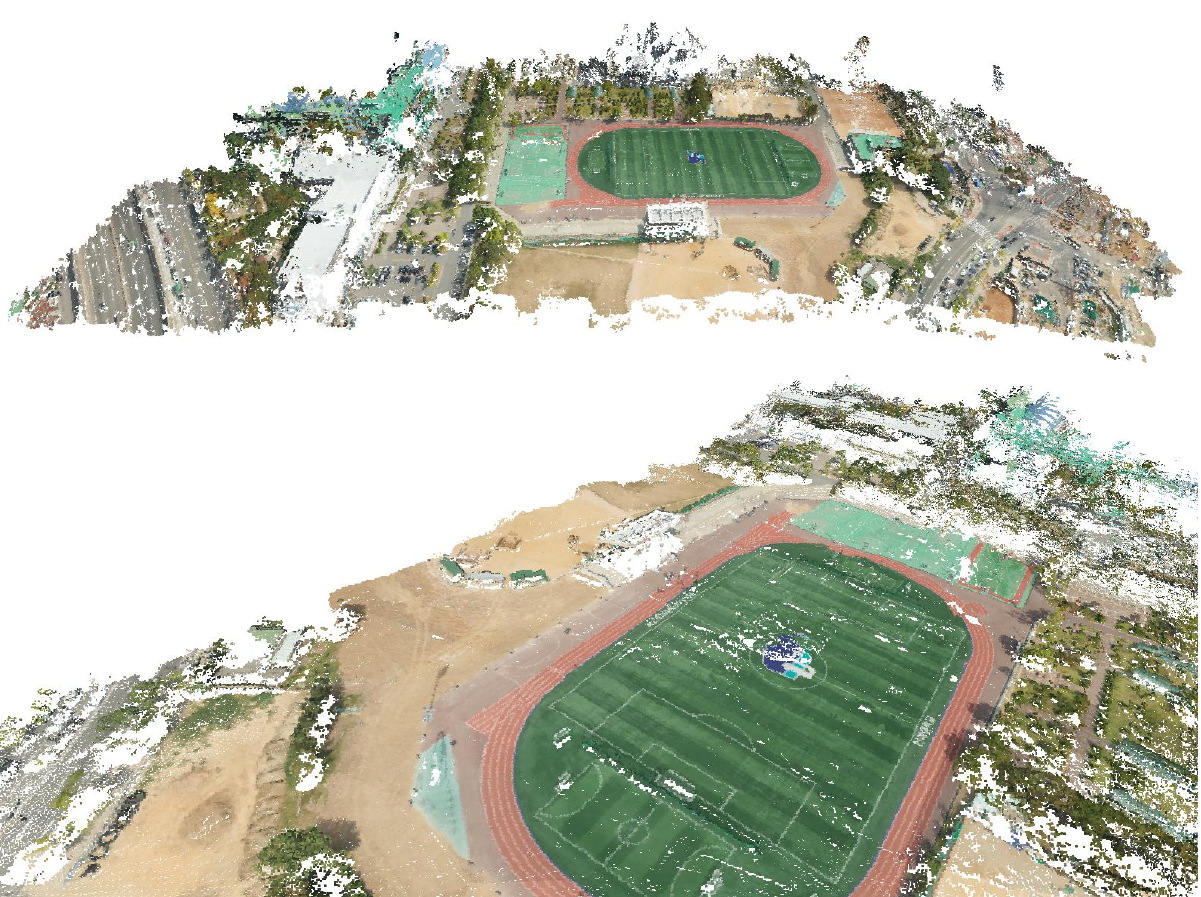
Figure 11. Point cloud results with colour information (using object space-based